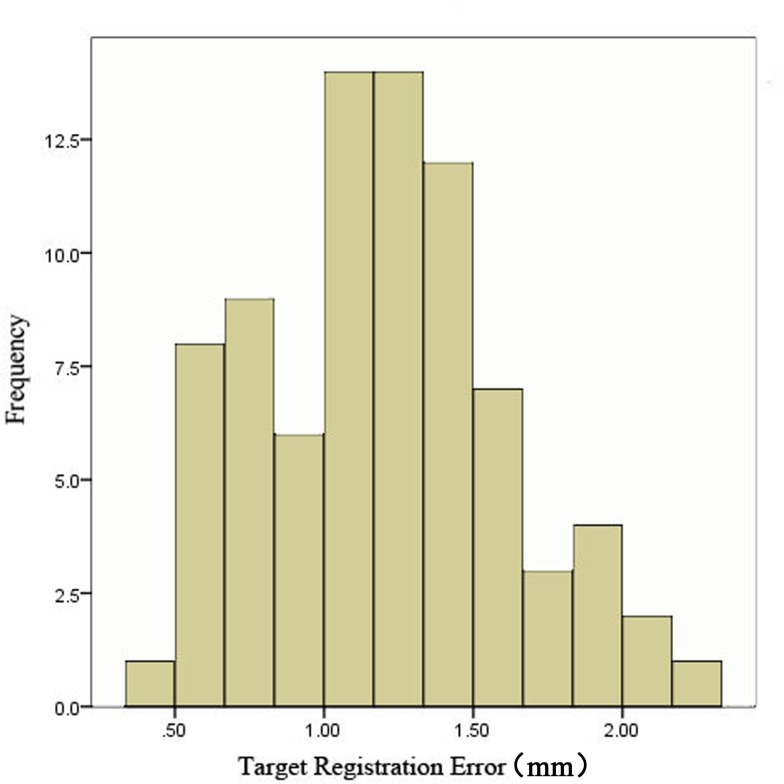
Frequency distribution of target registration error (TRE) during the head phantom experiment.